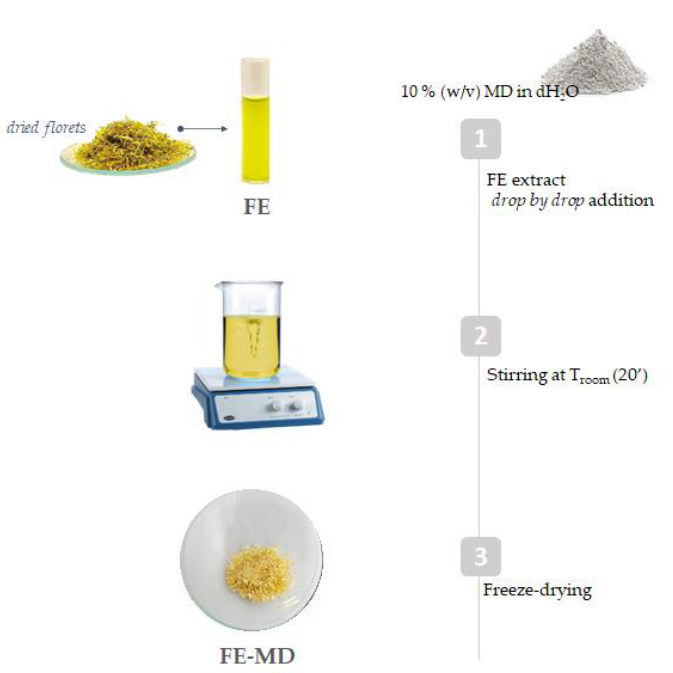
Figure 8. Encapsulation scheme applied to field marigold floret extract (MD = maltodextrin; FE = floret extract).